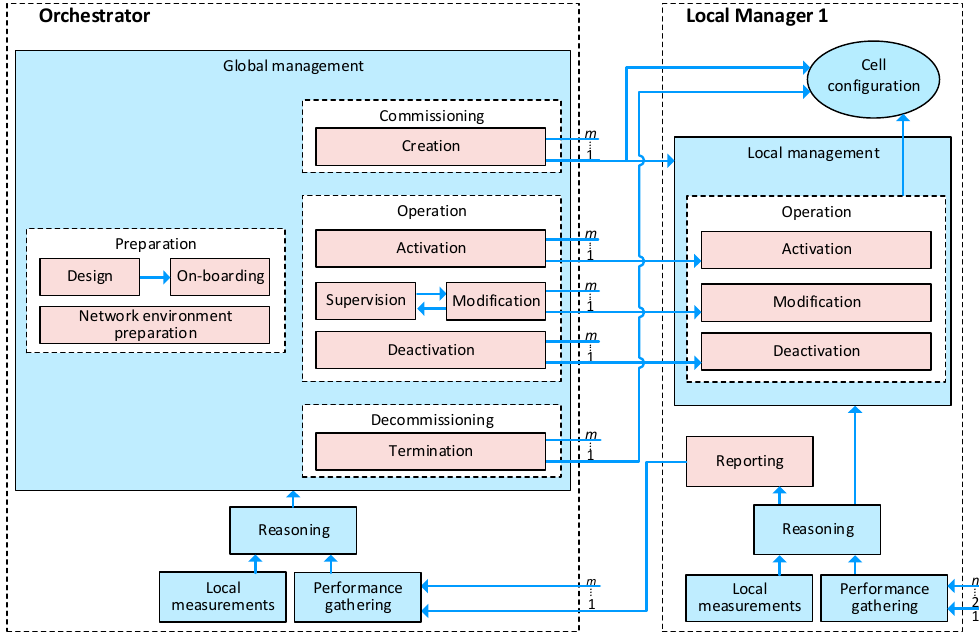
Figure 8. Management aspects of RAN slices supported by the hybrid communication management architecture (red squares represent RAN slices management tasks defined in [44]).